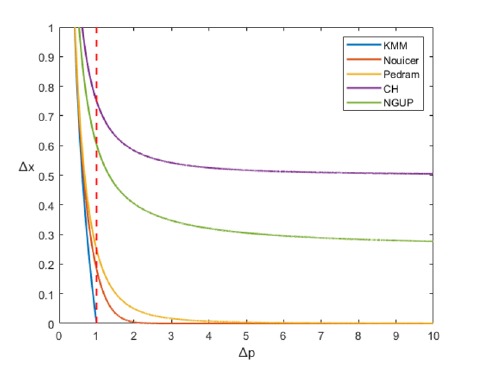
Figure 2 . The ∆ x as the functions on ∆ p for β < 0 respectively given by KMM, Nouicer, Pedram, CH and NGUP. The red dotted line represents the position of the maximum momentum.